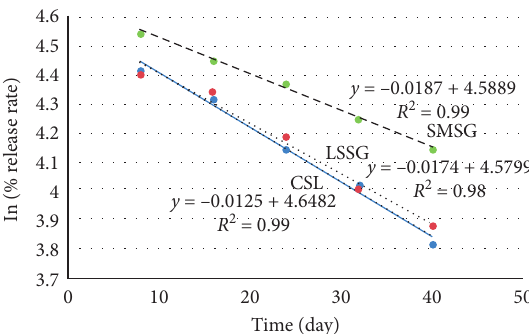
Figure 2: Release rate and regression equations of phenolic compounds of nanocapsules coated with of SMSG (1), LSSG (2), and mix (3). SMSG, Salvia macrosiphon Seed Gum; LSSG, Lepi- dium sativum Linn. Seed Gum; and CSL, complex of SMSG and LSSG (1